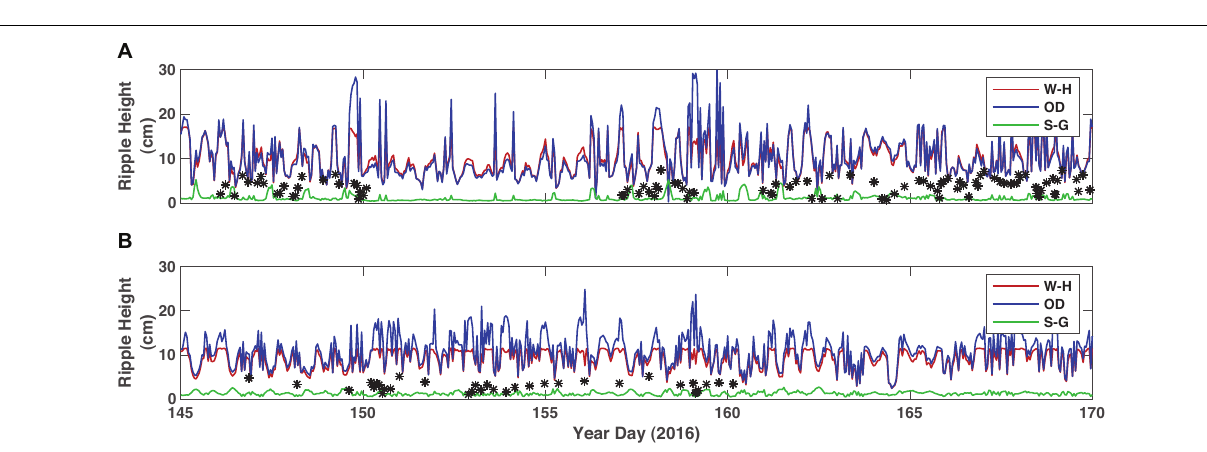
FIGURE 10 | Shields parameters by forcing mechanism for the three sites. (A) Waves. (B) Currents. Color represents the site location: Red = TR1 on the outer reef flat near the reef crest, green = TR2 on the inner reef flat, and blue = TR3 in the lagoon.